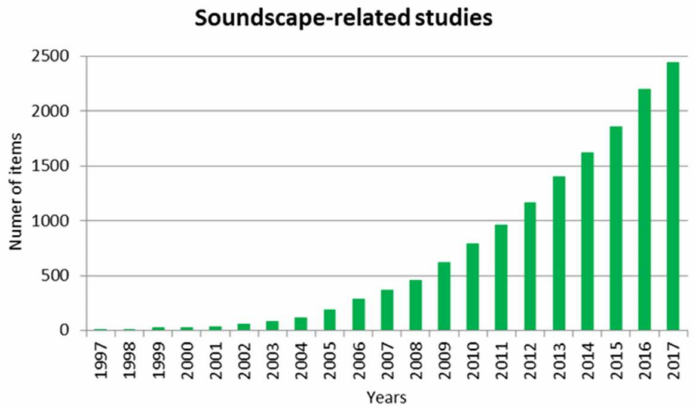
Figure 1. Cumulative sum of documents retrieved in the Scopus ® database using “soundscape” as search term: TITLE-ABS-KEY